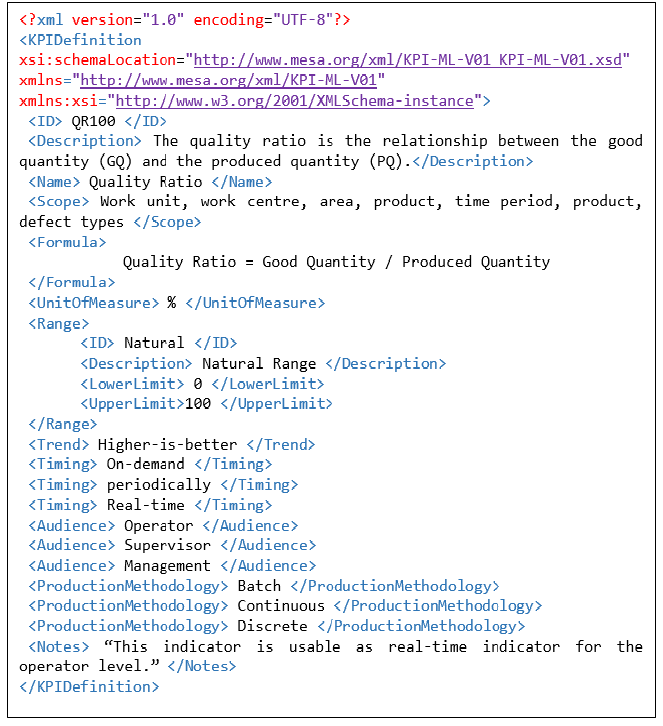
Figure 1. XML Implementation of the KPI description in ISO 22400-2 [14,18].